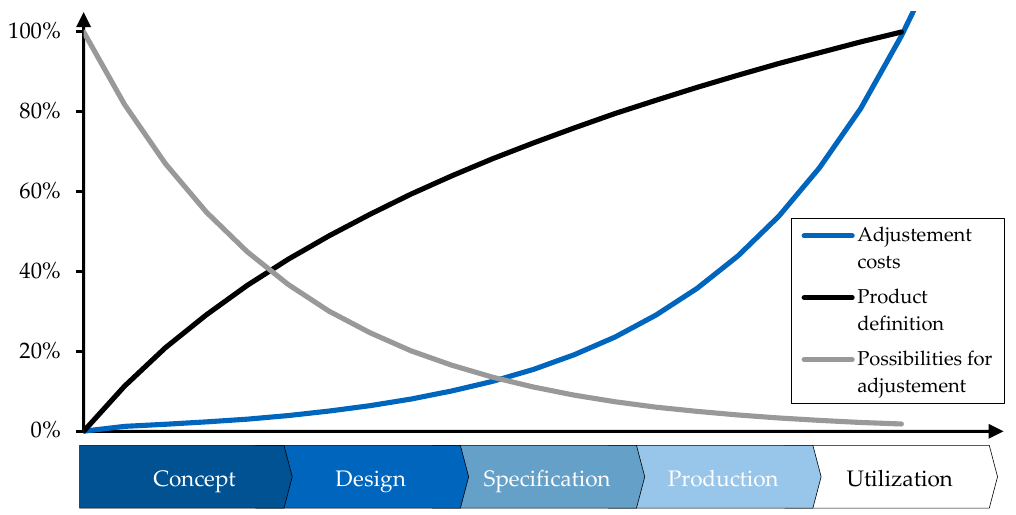
Figure 1. Overview of the costs in the product development cycle, based on [2] (p. 15..9)